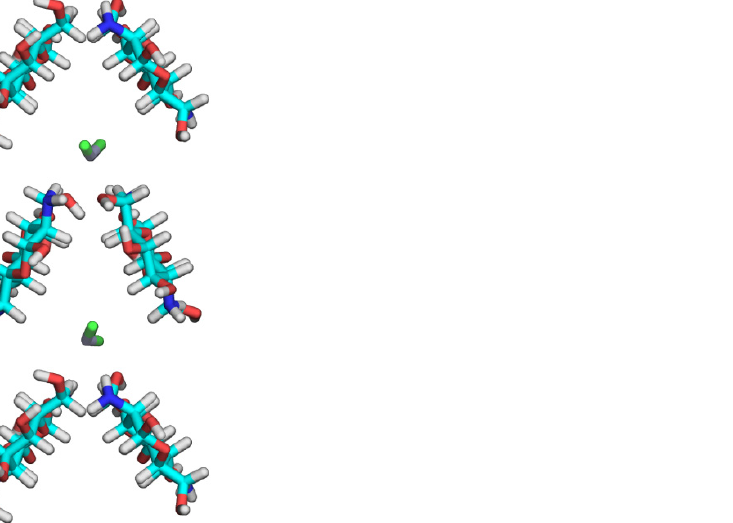
Figure 5. Projections of the SEQM-optimized structure of the crystal model on the ab base planes.